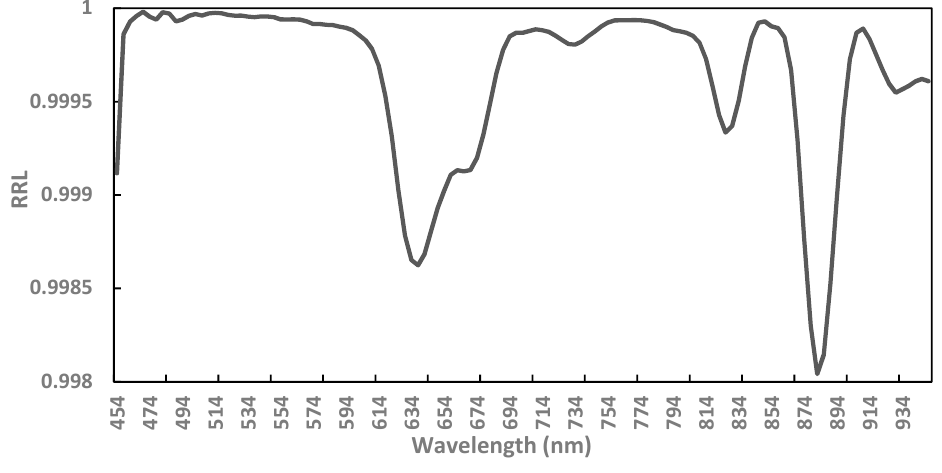
Figure 5. Linearity of pixel responses for all bands.